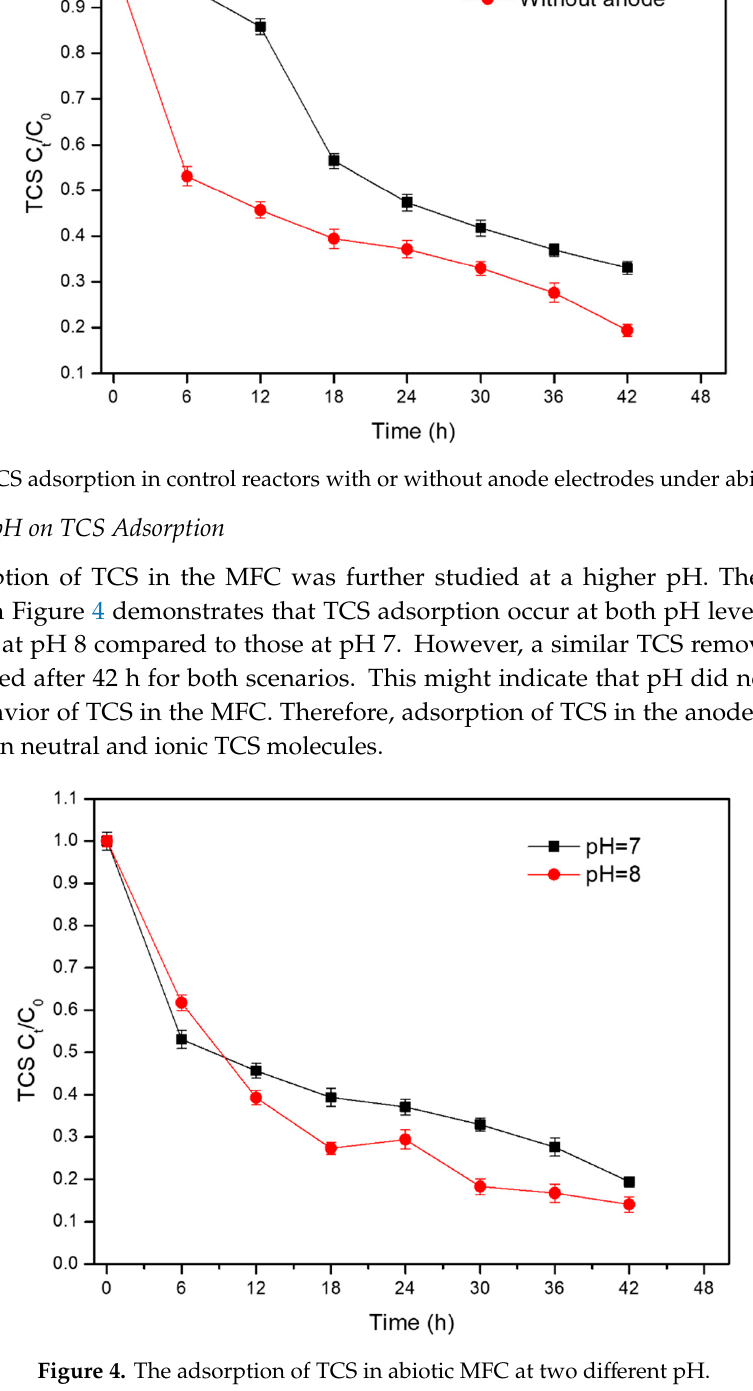
Figure 4. The adsorption of TCS in abiotic MFC at two different pH.